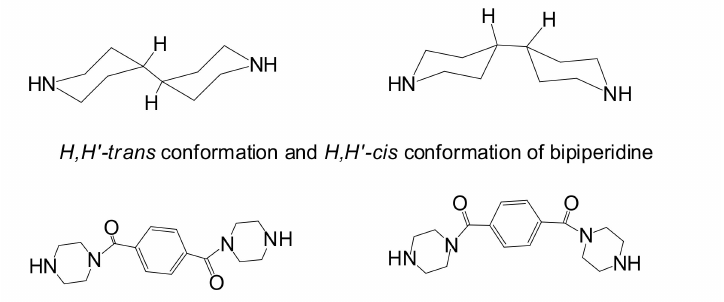
Figure 5. The cis and trans of 4,4 (cid:48) -bipiperidine and terephaloyl piperazine.